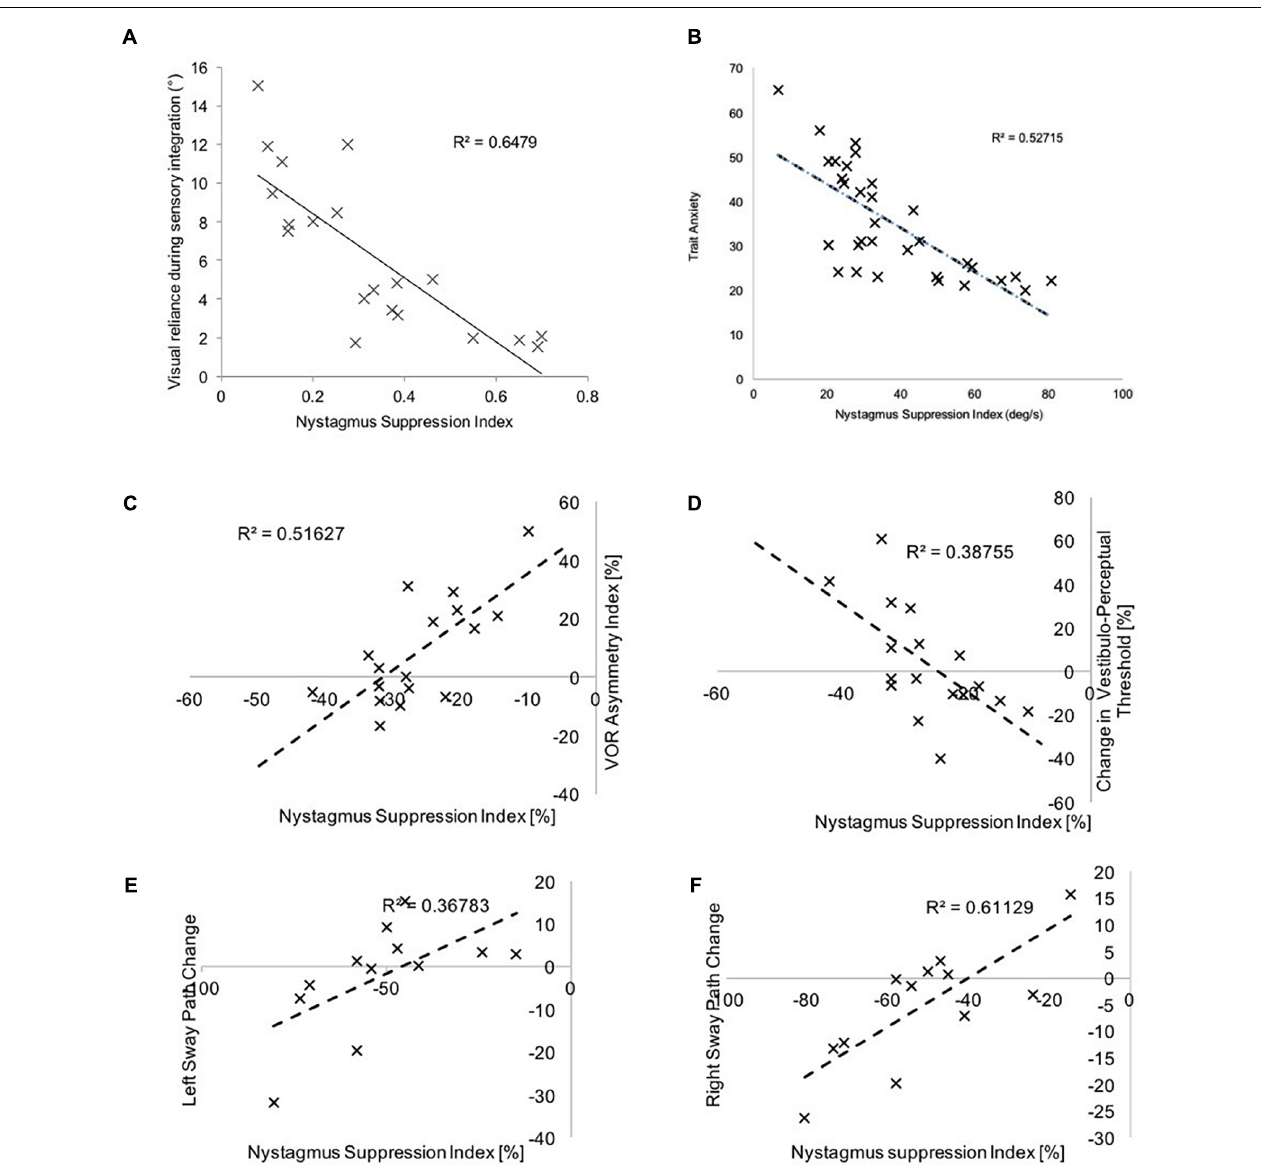
FIGURE 6 | Here we represent the relationship between the NSI (following left PPC cathodal stimulation) and (A) visual dependency-assessed using the rod and disk task, (B) trait anxiety assessed using the Spielberger questionnaire, (C) vestibulo-ocular thresholds during yaw rotations, (D) vestibulo-perceptual thresholds during yaw rotations, (E) sway velocity during leftward body motion and, (F) sway velocity during rightward motion. Greater NSI indicates increased right-hemispheric vestibulo-cortical dominance, and this is associated with (A) reduced reliance upon visual cues during sensory integration, (B) reduced trait anxiety, (C,D) reduced motion detection thresholds, and, (D,E) reduced sway